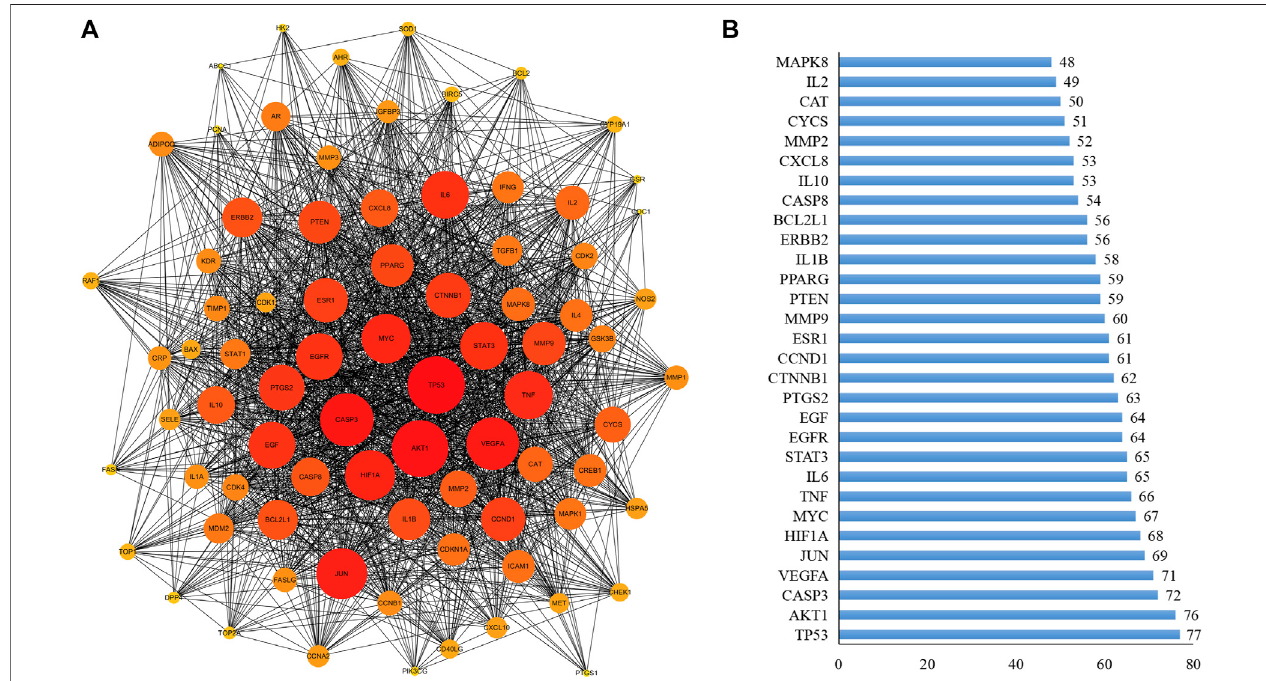
FIGURE2| PPIanalysis. (A) ThePPIwasconstructedbySTRINGdatabases.Nodesizeanddepthofgenetargetsareproportionaltothedegrees; (B) PPIanalysis for the top 30 targets.